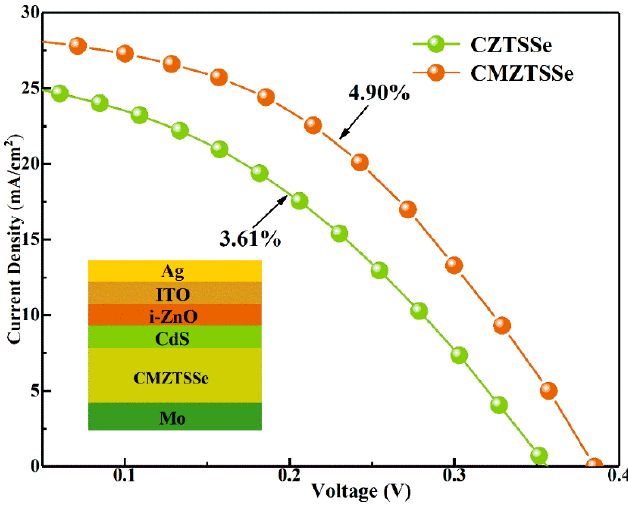
Figure 7. Current-voltage characteristics of the CZTSSe and Cu 2 Mn x Zn 1 − x Sn(S,Se) 4 ( x = 0.1) devices.